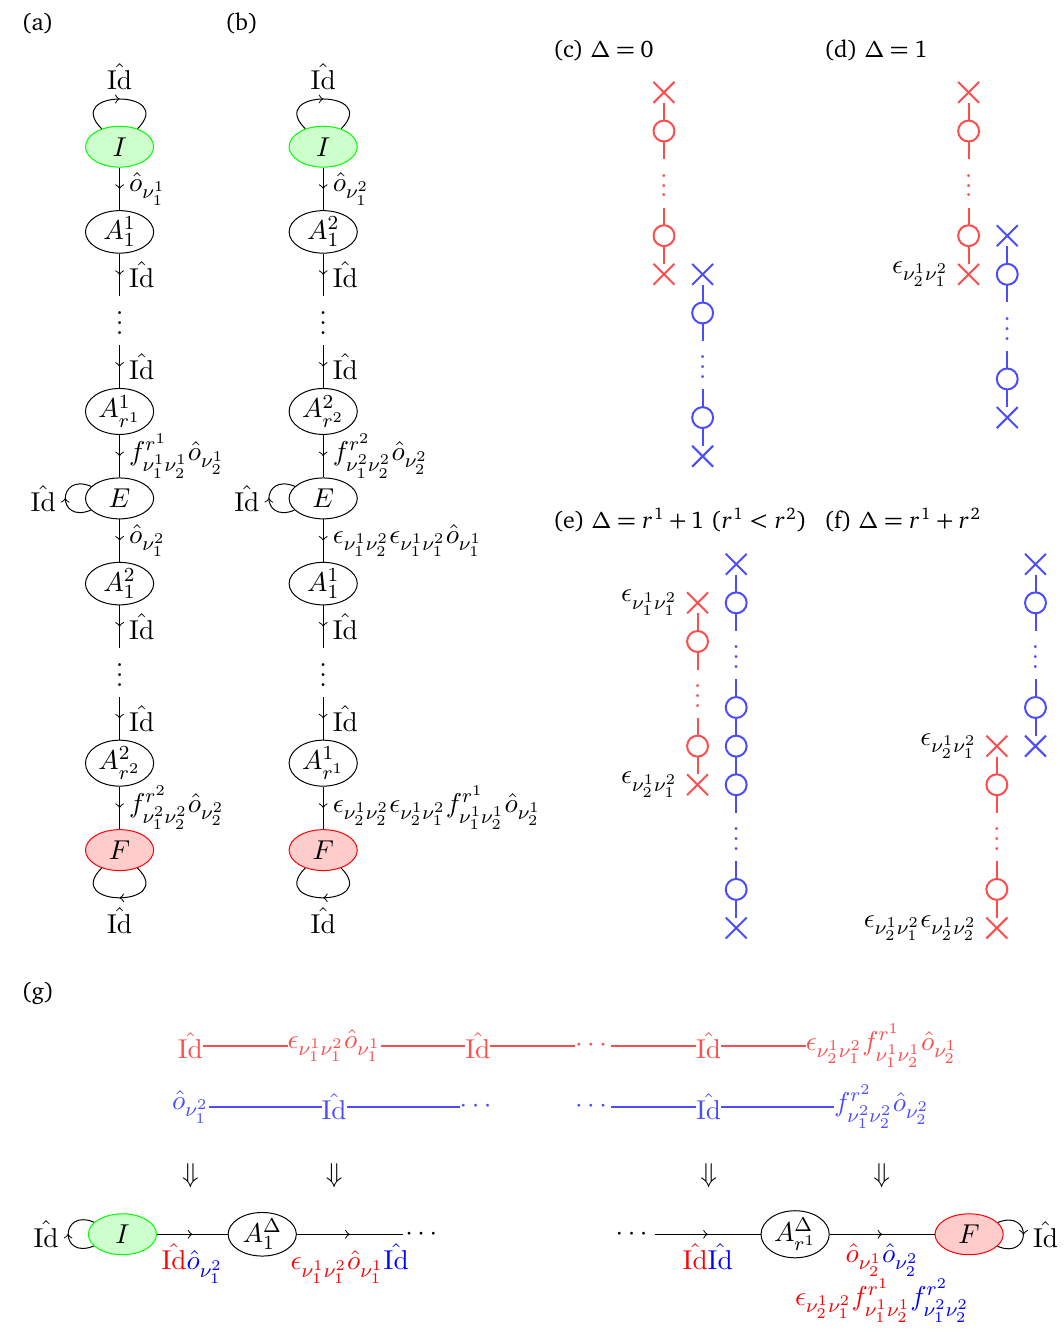
Figure 12: (a) Tree diagram representation of ˆ H (c-f) The figures depict stages of the algorithm for determining all summands ˆ h shifting the operator string ˆ h with the initial local operator of the other operator string ˆ h Resubstituted local operators at step ∆ = r 1 + 1 with r 2 = r 1 + 1. The created operator string ⊗ ε ⊗ ˆId ⊗ ··· ⊗ ˆId ⊗ ε ˆ o ν 1 is ˆ o ν 2 ν 1 ν 2 1 1 1 1